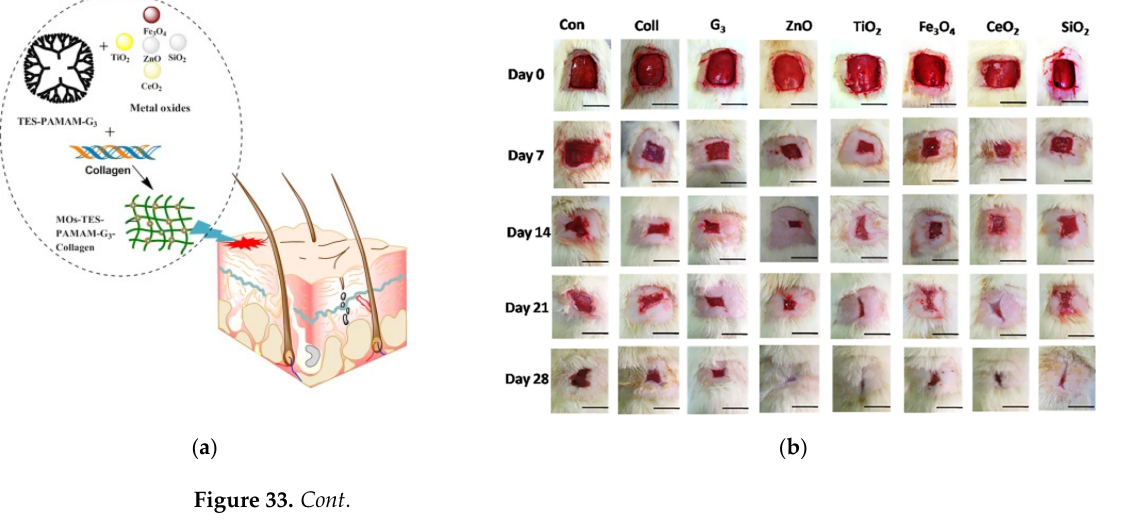
( f ) Figure 33. ( a ) Schematic diagram of the construction of collagen scaffolds ( b ) Representative photo- graphs of excisional wounds on Wistar albino rats at different time intervals following treatment with ZnO, TiO 2 , Fe 3 O 4 , CeO 2 , and SiO 2 . Scale bar: 5 mm. Both are published with permission from [280]. Copyright: Springer Nature. ( c ) Schematic diagram depicting the method of combining dif- ferent shaped ZnO-TES-PAMAM-G1 Nps with collagen scaffold. ( d ) The wound healing capacity of collagen, collagen-TES-PAMAM-G1, and variable morphology of ZnO nanoparticle cross-linked collagen scaffold on Wistar Albino rats at days 1, 7, 14, and 21. Both are published with permission from [281]. Copyright: American Chemical Society. ( e ) Schematic representation of the production